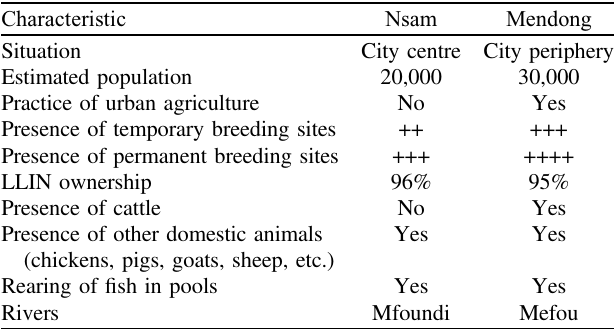
Table 1. Characteristics of the study sites in Nsam and Mendong